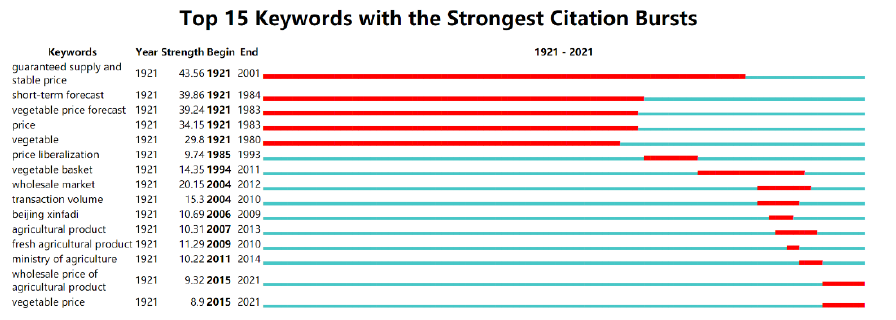
Figure 7. The Evolution of CNKI Vegetable Price Research.